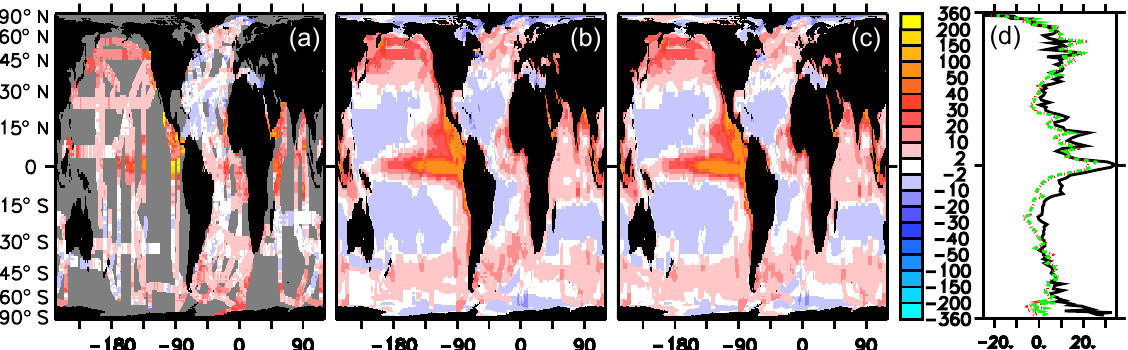
Figure 11. Surface (cid:49)p N 2 O (ppb). (a) Observations (symbol size is 5 ◦ × 5 ◦ ). (b) Optimised diagnostic model. (c) Optimised prognostic model. Model results are for the same months where there are observations, and annual averages everywhere else. (d) Zonal average. Black line: observations; green dashed: diagnostic model; red dotted: prognostic model. Model results are for the same months and longitudes as the observations. Latitude y axis to the left of panel (a) . Table 2. Contributions of coastal (bottom depth ≤ 200m), near-shore non-coastal ( ≤ 2 ◦ from land, bottom depth > 200m), eastern equatorial Pacific (180–70 ◦ W 5 ◦ S–5 ◦ N, > 2 ◦ from land) and rest of the open ocean ( > 2 ◦ from land, bottom depth > 200m, excluding eastern equatorial Pacific) to N 2 O flux, area and number of observations. Region Submodel N 2 O flux %N 2 O flux %area % n obs Coastal